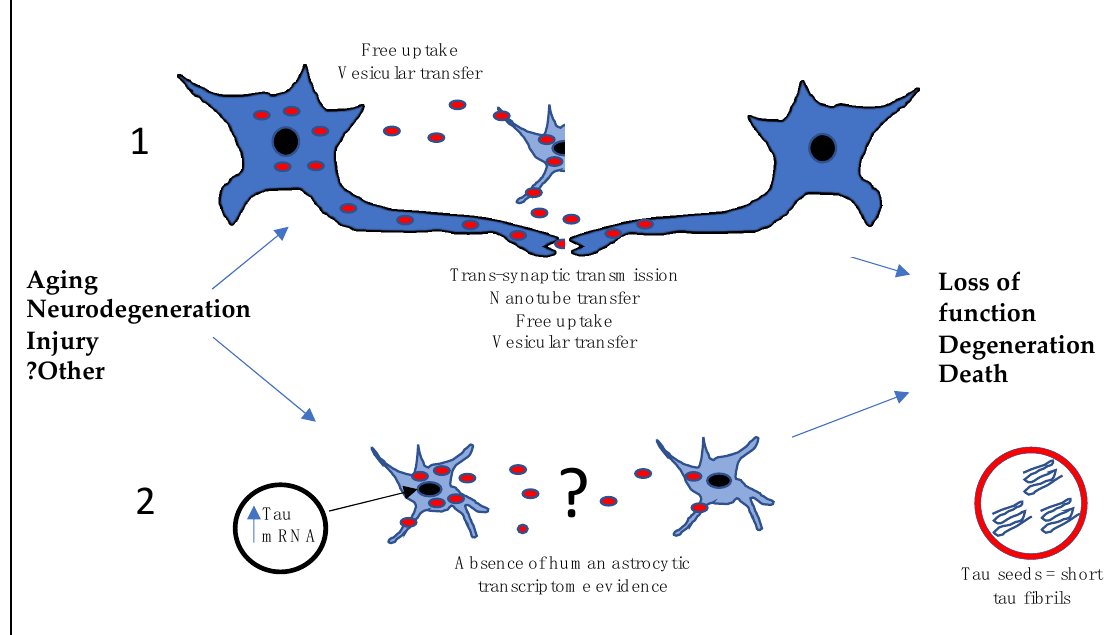
Figure 3. Schematic of two astrocytic tau propagation hypotheses. Small tau fibrils or “seeds” (red dots) may be formed in the cytoplasm of neurons or astrocytes after release from endosomal vesicles. Dissemination may occur from neuron-to-neuron by mechanisms such as trans-synaptic transmission, free uptake or vesicular or nanotube transfer to neighboring cells, while neuron-to-astrocyte and astrocyte-to-astrocyte transmission is not clear and may occur via trans-synaptic transmission, vesicular uptake or free transfer. Hypothesis 1 relies on neuronal release of tau, which is taken up by nearby astrocytes. Hypothesis 2 sees astrocytes upregulate tau and kinase expression leading to tau hyperphosphorylation and spread to other cells, however there is currently little evidence to support this.